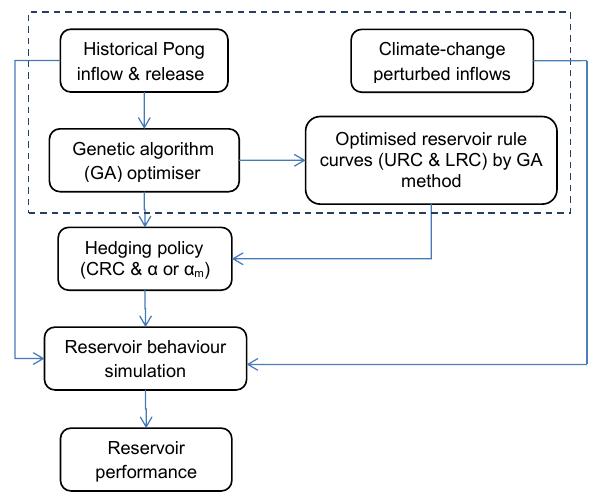
Figure 2. Methodology flow chart for optimising and performance evaluation of the hedging